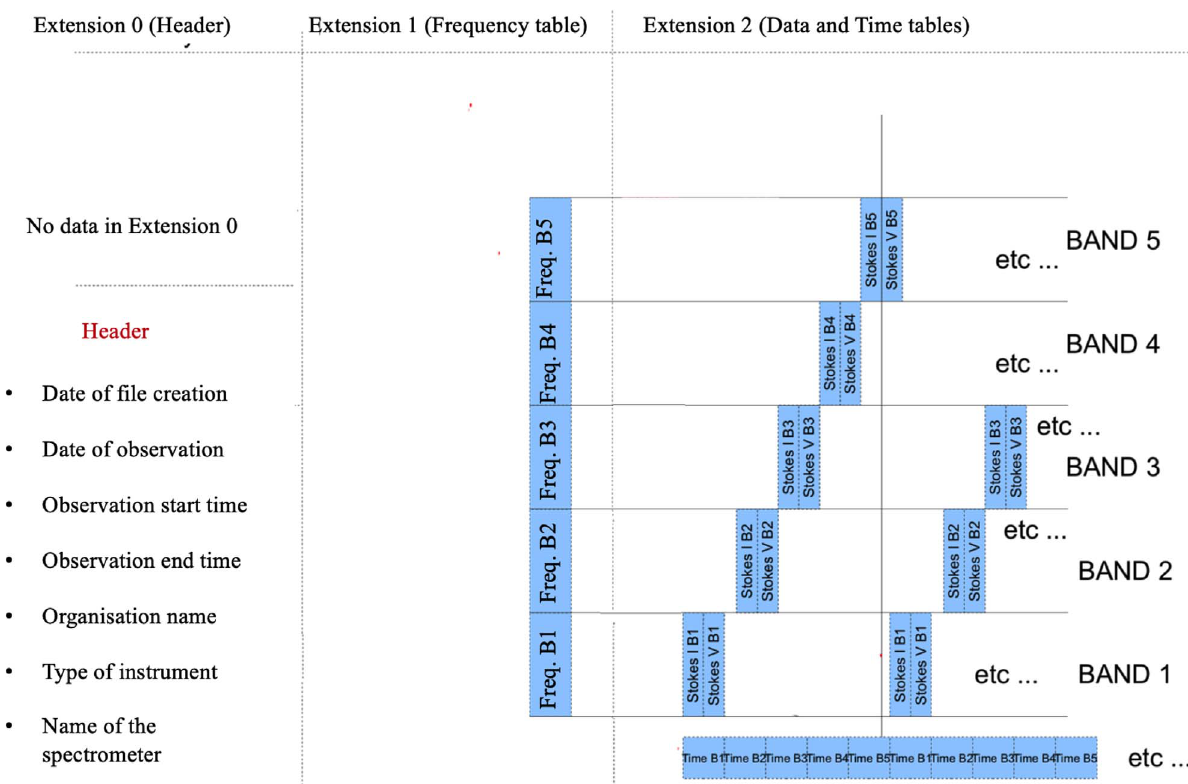
Fig. 5. ORFEES FITS data format description.